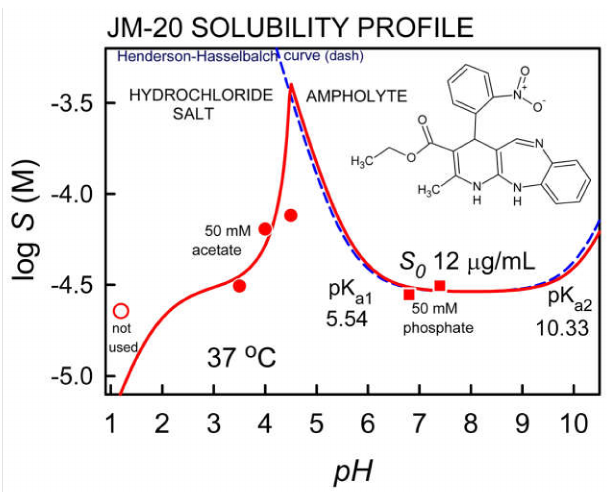
Figure 1. pH-dependent solubility profile of JM-20 (points are solubility values measured by shake- flask method; dashed-line is the theoretical HH curve). Table 2. Experimental solubility values and number of doses for